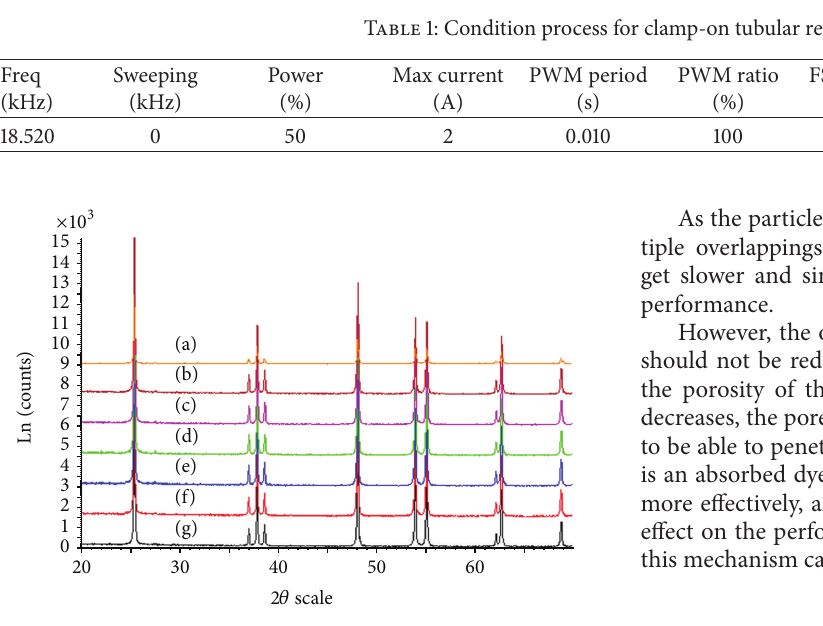
Figure 2: XRD patterns of TiO 2 powders (a) without ultrasonic process and the rest. (b) 10 minutes, (c) 20 minutes, (d) 30 minutes, (e) 40 minutes, (f) 50 minutes, and (g) 60 minutes, via ultrasonic process,